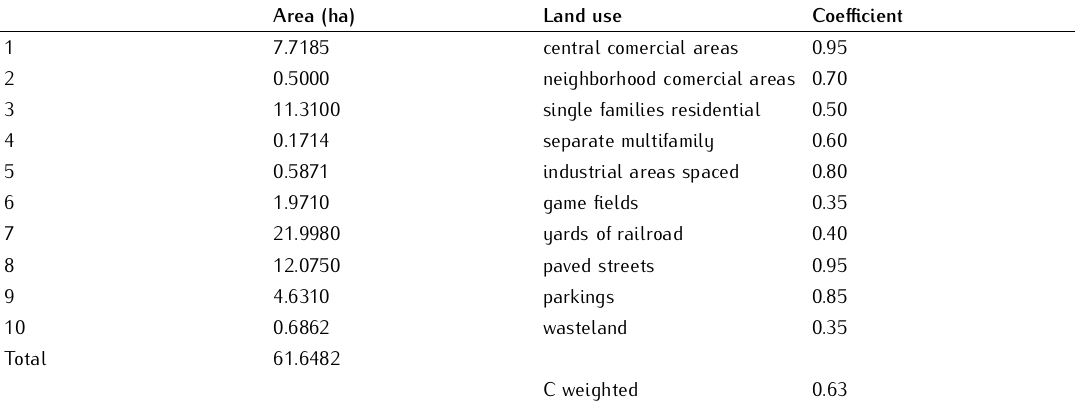
Table 1. Runoff coefficient and area of the diferent uses for the sub-basin II.